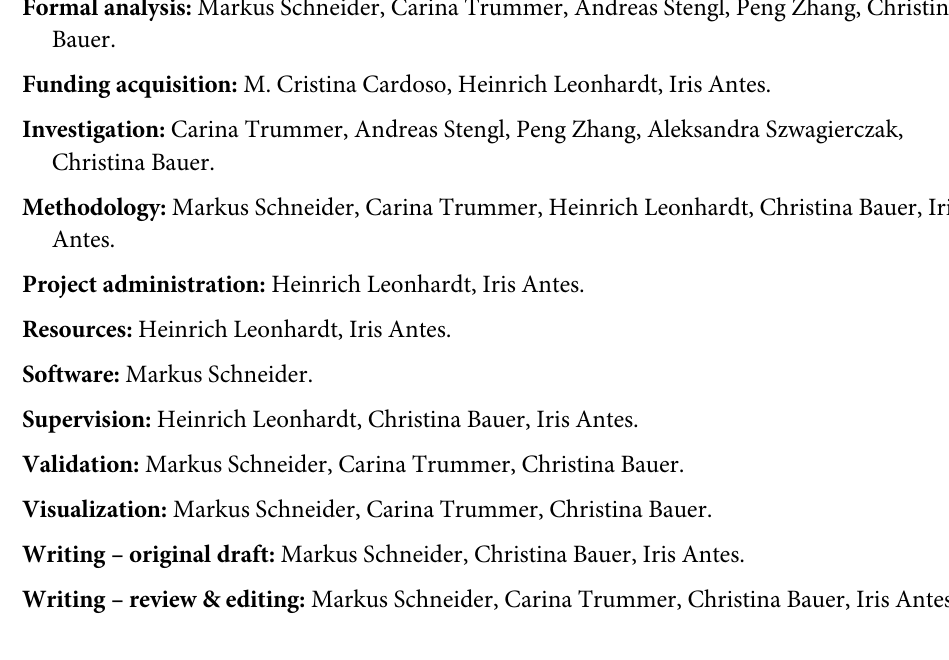
function (pdf). The estimated pdf of the mC-C’ system is shown as black dashed lines. (TIF) S9 Fig. Distribution of DNA minor groove widths in molecular dynamics trajectories of UHRF1-SRA. Blue faces represent gaussian kernel estimates of the underlying values. Black bars show distribution means and standard deviations. (TIF) S10 Fig. Distribution of DNA major groove widths in molecular dynamics trajectories of UHRF1-SRA. Blue faces represent gaussian kernel estimates of the underlying values. Black bars show distribution means and standard deviations. (TIF) S1 Text. Additional experimental procedures. (DOCX) S1 File. Parameter files for mC/caC used during molecular dynamics